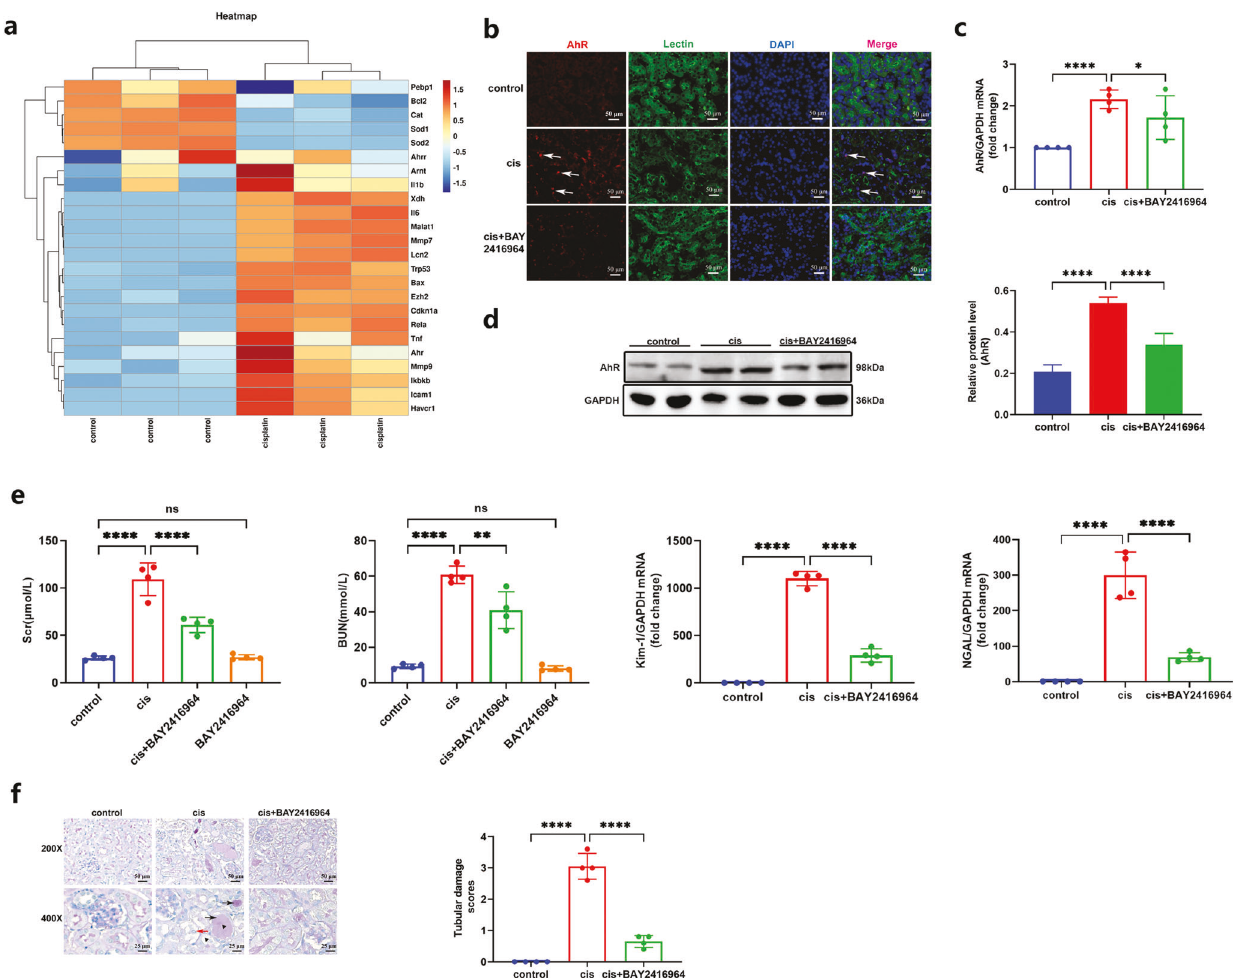
Fig. 1 AhR antagonist BAY2416964 alleviated tubular injury in cisplatin-induced AKI mice. a The cluster heatmap was conducted to present differentially expressed genes in the GSE106993 dataset ( n = 3). b Representative micrographs of AhR (red) with tubule marker Lectin (green) by immuno fl uorescence staining of kidney tissues (×200). c , d The mRNA and protein levels of AhR, and the relative protein level of AhR was quanti fi ed by densitometry and normalized with GAPDH ( n = 3); All western blot protein samples were taken from two random mice in a different group, and the experiments were repeated three times. e The biochemical levels and mRNA expression of Kim-1 and NGAL ( n = 4); f Representative PAS staining sections of kidney tissues were magni fi ed ×200 and ×400, and tubular damage scores were